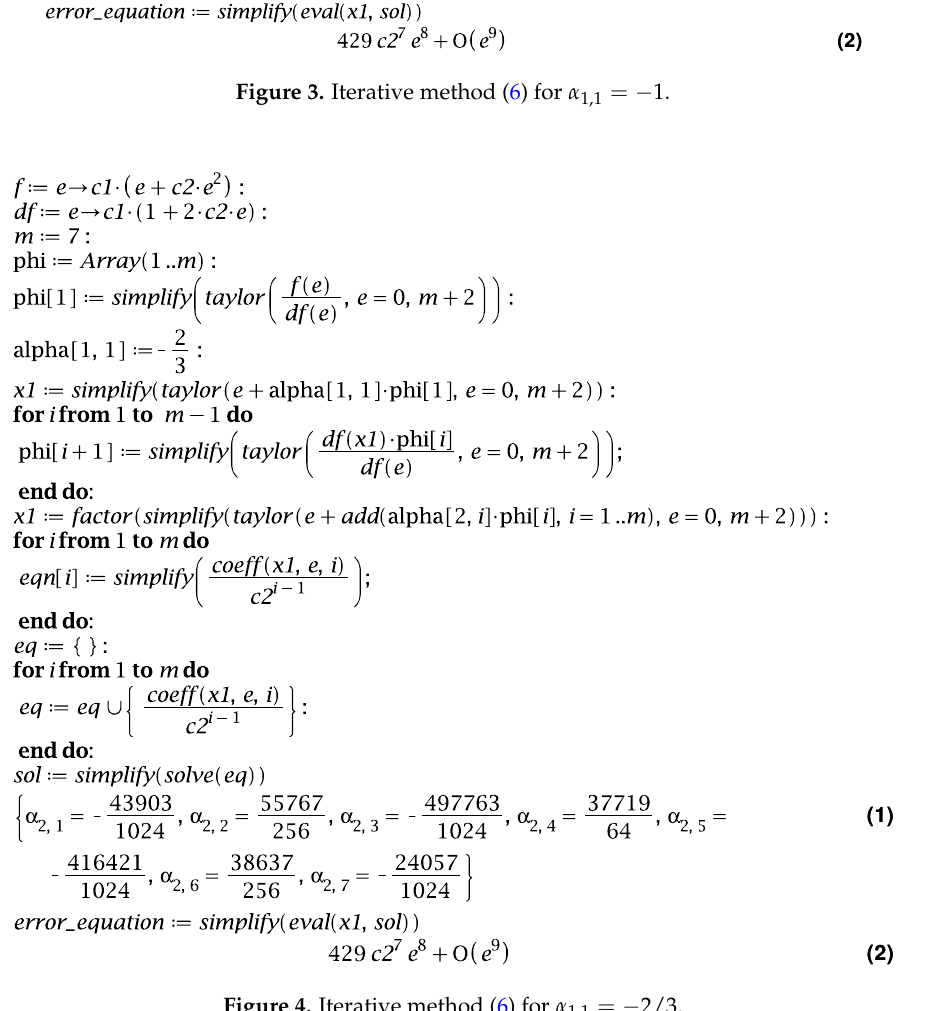
Figure 3. Iterative method (6) for α 1,1 = − 1.